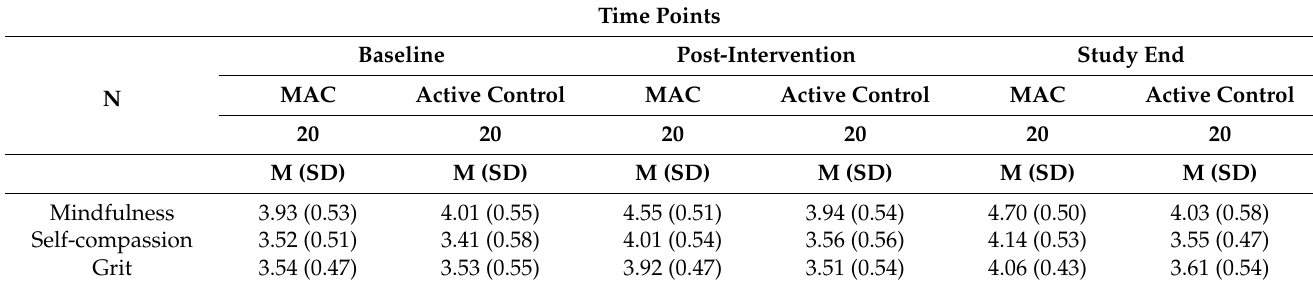
Table 3. Descriptive statistics for outcome variables at baseline, at post-intervention and at the end of the study, separately for participants in the Mindfulness–Acceptance–Commitment (MAC) and the active control condition. Table 4. Inferential statistics for outcome variables at baseline, at post-intervention and at follow-up, separately for participants in the MAC = Mindfulness–Acceptance–Commitment (MAC) and the active control condition.